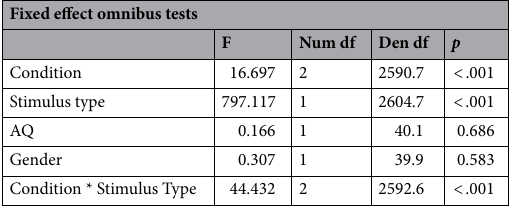
Table 1. Parameter estimates for the fixed effect omnibus